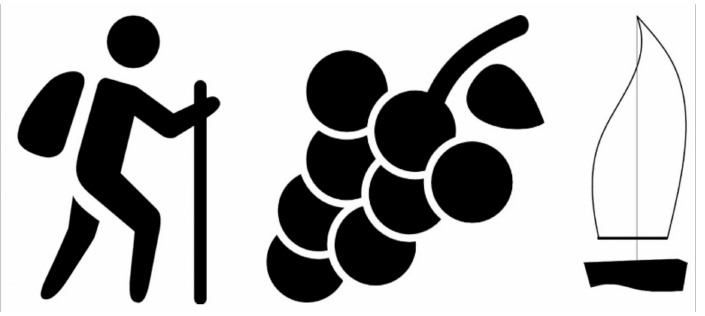
Figure 5. Subdivision by geographical elements.